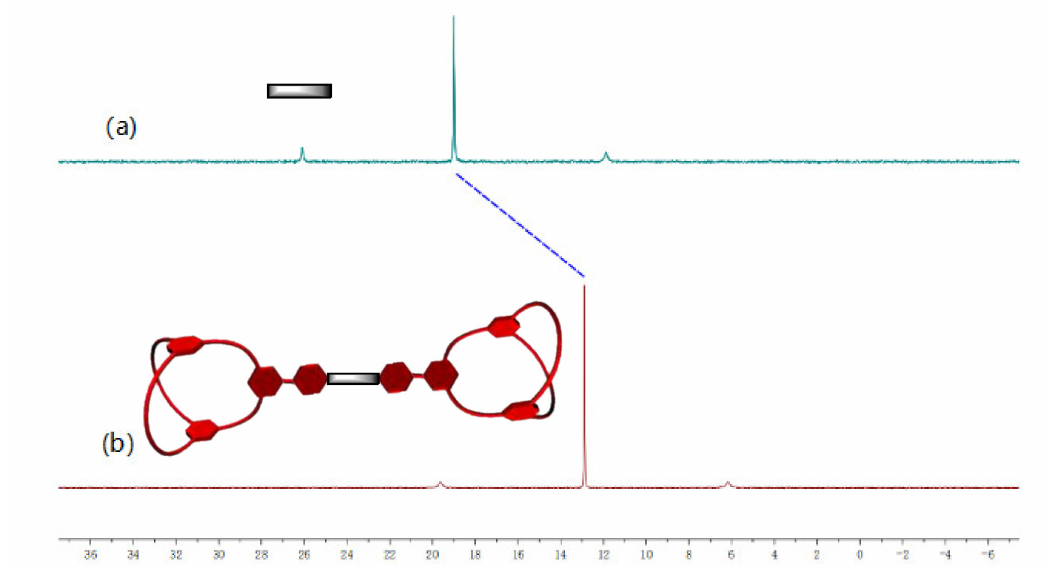
Figure 3. 31 P{ 1 H} NMR spectra (202 MHz, CD 2 Cl 2 , 298 K): ( a ) the bidentate organoplatinum(II) acceptor 5 and ( b ) the di-cryptand monomer 8